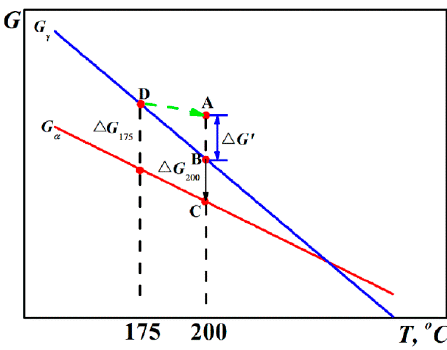
Figure 7. Evolution of free energy of austenite (G γ ) and ferrite (G α ) with decreasing temperature.